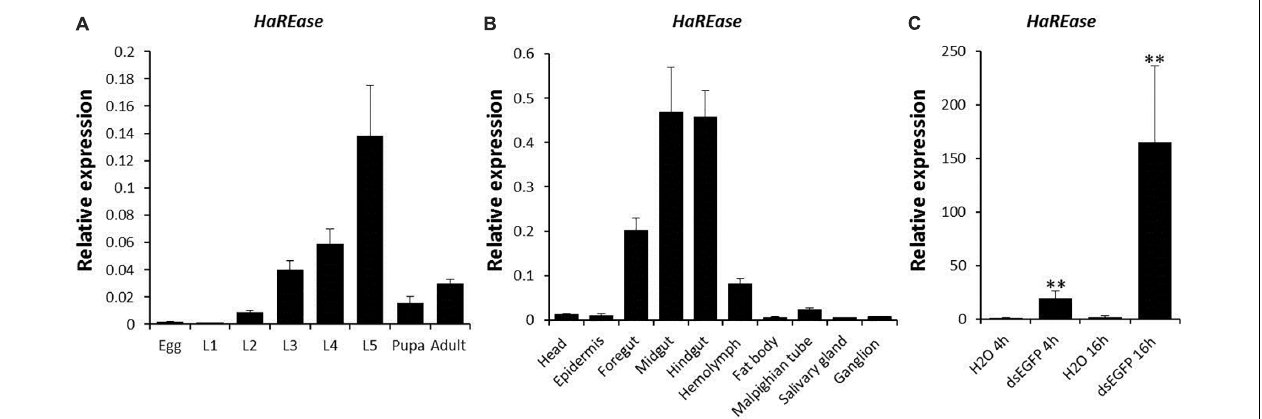
FIGURE 1 | Expression patterns of HaREase in cotton bollworm by RT-qPCR. (A,B) Expression patterns of HaREase in different development stages (A) and different tissues (B) . L1–L5, First to fifth instar larvae. (C) Expression of HaREase after dsEGFP treatment for 4 and 16 h. Data are mean SD, n = 3. ∗∗ P < 0.01.